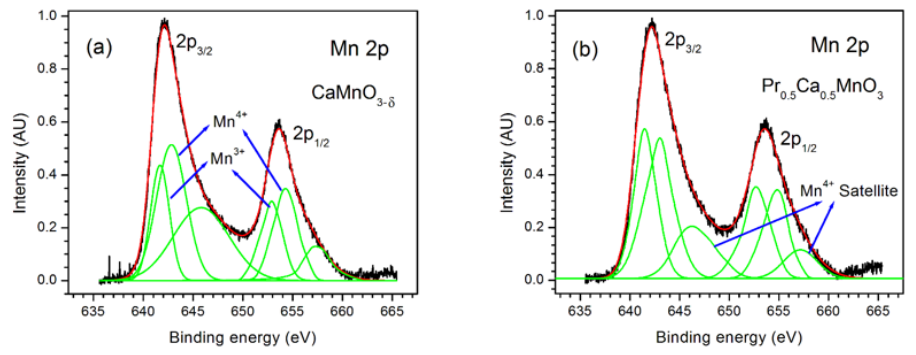
Figure 5. Energy spectroscopies of Mn 2p recorded for ( a ) CaMnO 3 −δ and ( b ) Pr 0.5 Ca 0.5 MnO 3 nanoparticles. The peaks in the 2p 3/2 region are assigned to the binding energies of Mn 3+ and Mn 4+ .